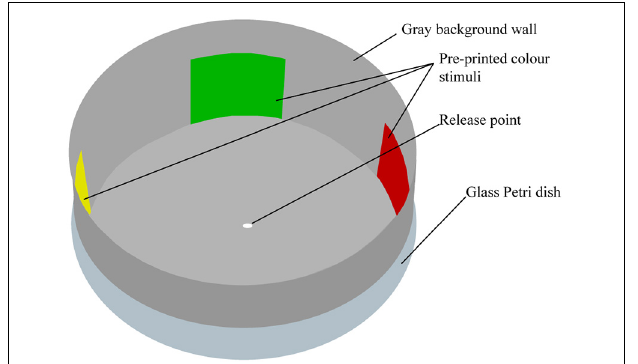
FIGURE 1 | Illustration of the color choice bioassay. Psyllids were placed initially on the white dot in the center of the arena and allowed 30min to choose one of the vertical color targets. A choice is considered to have been made when the psyllid adopts a vertical position on any area of the wall of the arena.